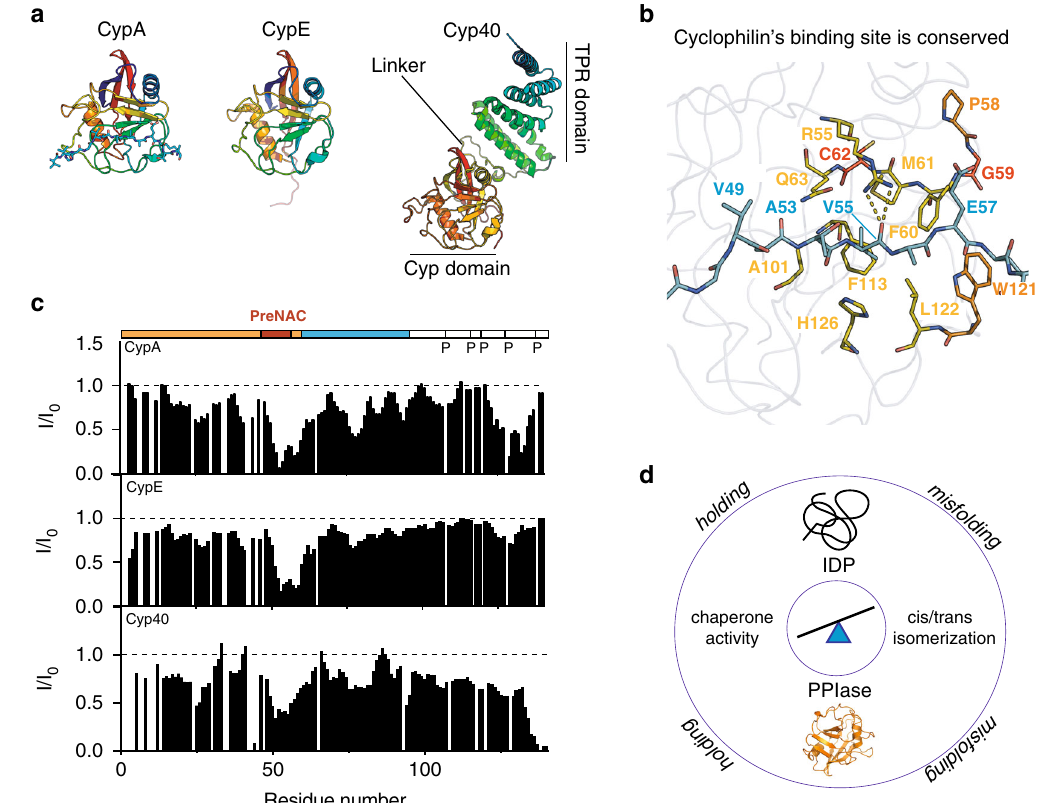
Fig. 7 Conserved dual mechanism of cis -/ trans -isomerization catalysis and molecular chaperone-like holding activity. a 3D structures of the three cyclophilins CypA (PDB code: 6I42), CypE (PDB code: 3UCH), and Cyp40 (PDB code: 1IIP). b Active site of CypA in complex with a peptide from the PreNAC region of aSyn (PDB code: 6I42). aSyn peptide residues labeled in blue. CypA residues of the active site are represented in yellow (conserved among CypA, CypE, and Cyp40), orange (residues mutated only in CypE or Cyp40), or red (residues not conserved among the three proteins). c Residue- speci fi c intensity changes induced in aSyn in the presence of a 5-fold excess of CypA (top), CypE (middle), and Cyp40 (bottom). I 0 and I are the intensities of 1 H – 15 N HSQC cross-peaks in the absence and presence of enzymes, respectively. The domain organization of aSyn and the location of proline residues is shown on top. d Schematic representation of the tug-of-war between catalysis of proline isomerization and molecular chaperone activity: PPIase-catalyzed cis -/ trans -isomerization lowers the energy barrier, which IDPs have to overcome during misfolding, while the chaperone-like holding activity of PPIases opposes